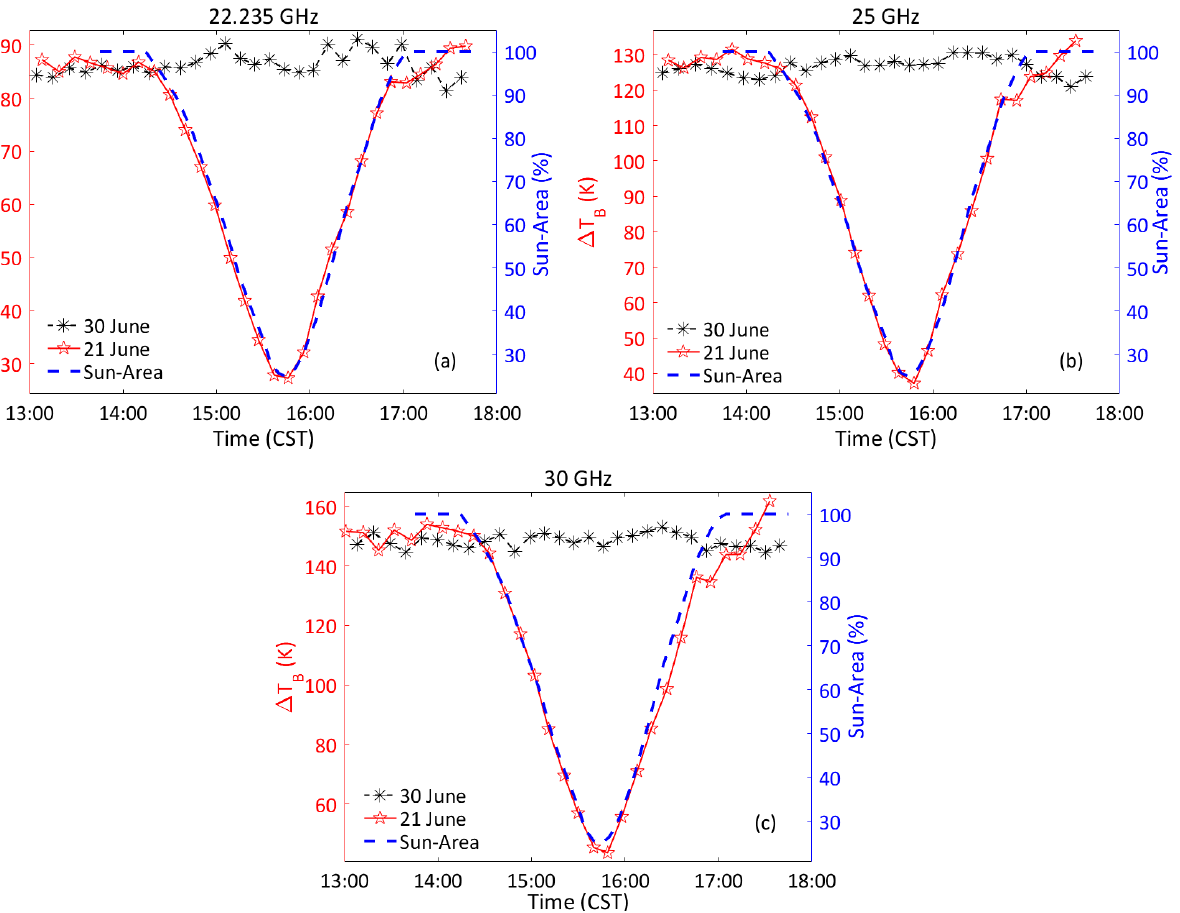
Figure 7. The variation of the T B increment (left axis) during the solar eclipse on 21 June 2020 (red solid curve with ☆ marks) as compared with that after the solar eclipse on 30 June (black curve with * marks). The blue dash line represents the percentage of the unshaded solar disk area (right axis). ( a ) 22.235 GHz, ( b ) 25.0 GHz, ( c ) 30.0 GHz.